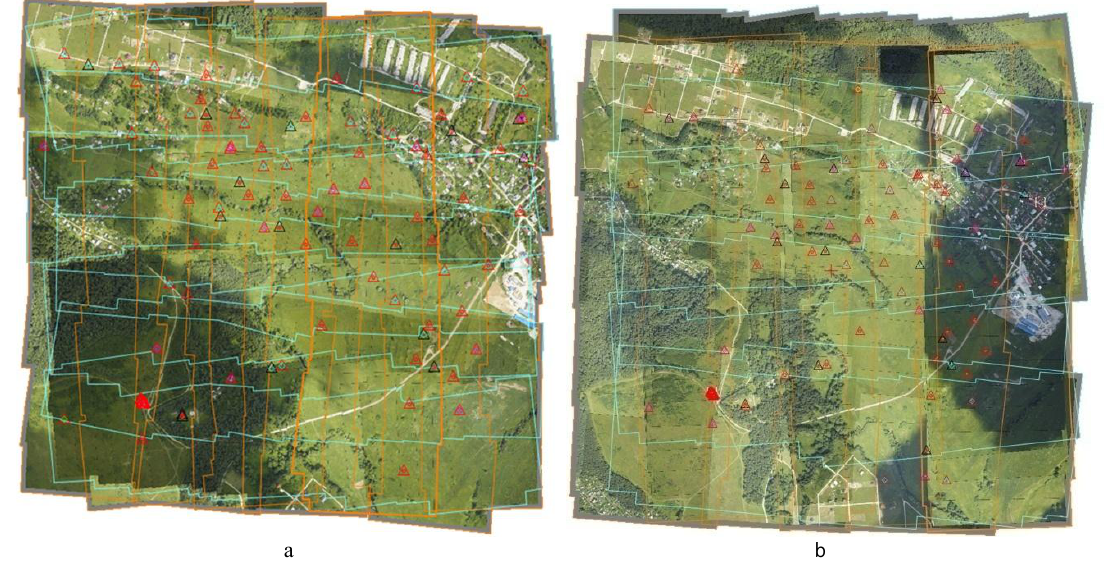
Figure 3. The Diagram of aerial photo: a - height shooting 600 meters; b - height of shooting 800